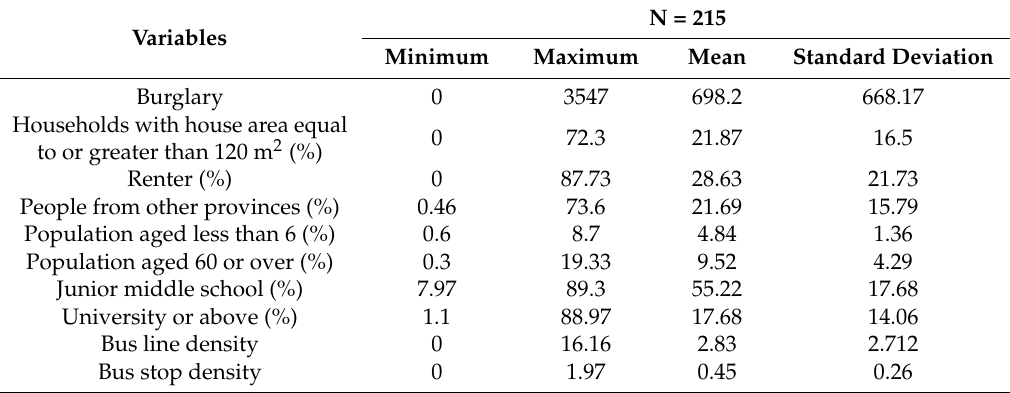
Table 1. Summary of Variable and Descriptive